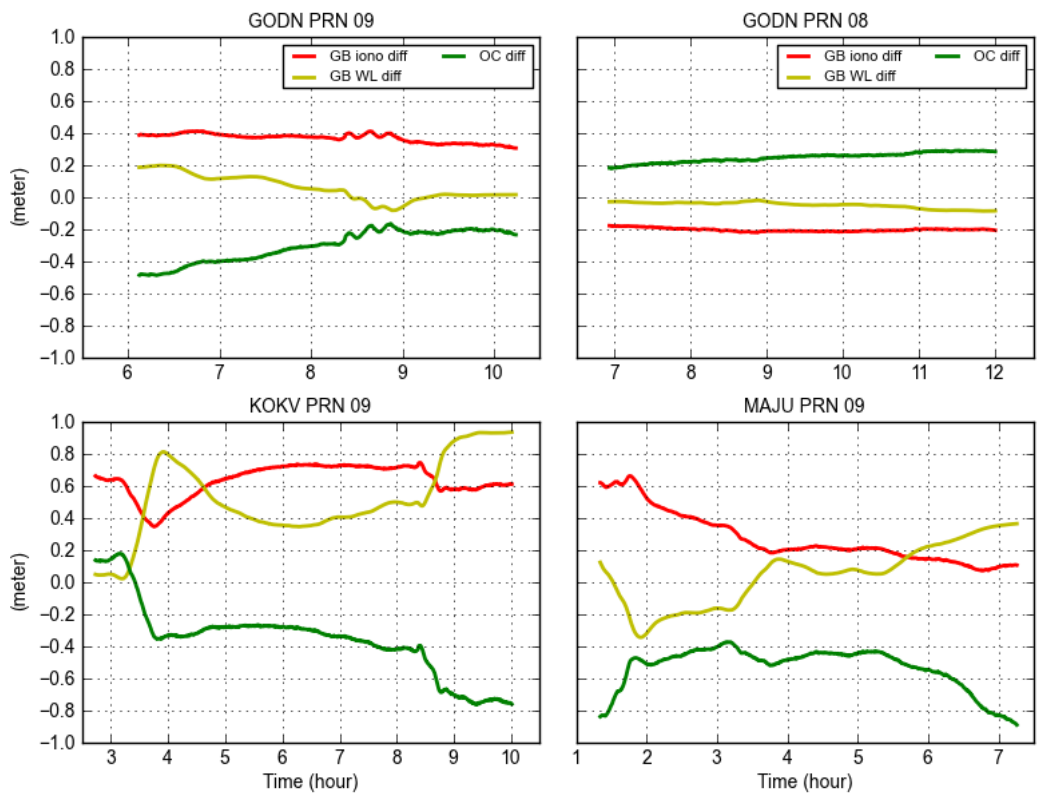
Figure 11. GB ionospheric delay differences (red), GB WL ambiguity differences (yellow), and OC differences (green) computed using final and real-time OC products for PRN 09 (top left) and PRN 08 (top right) at site GODN, PRN 09 (bottom left) at site KOKV, and PRN 09 (bottom right) at site MAJU.